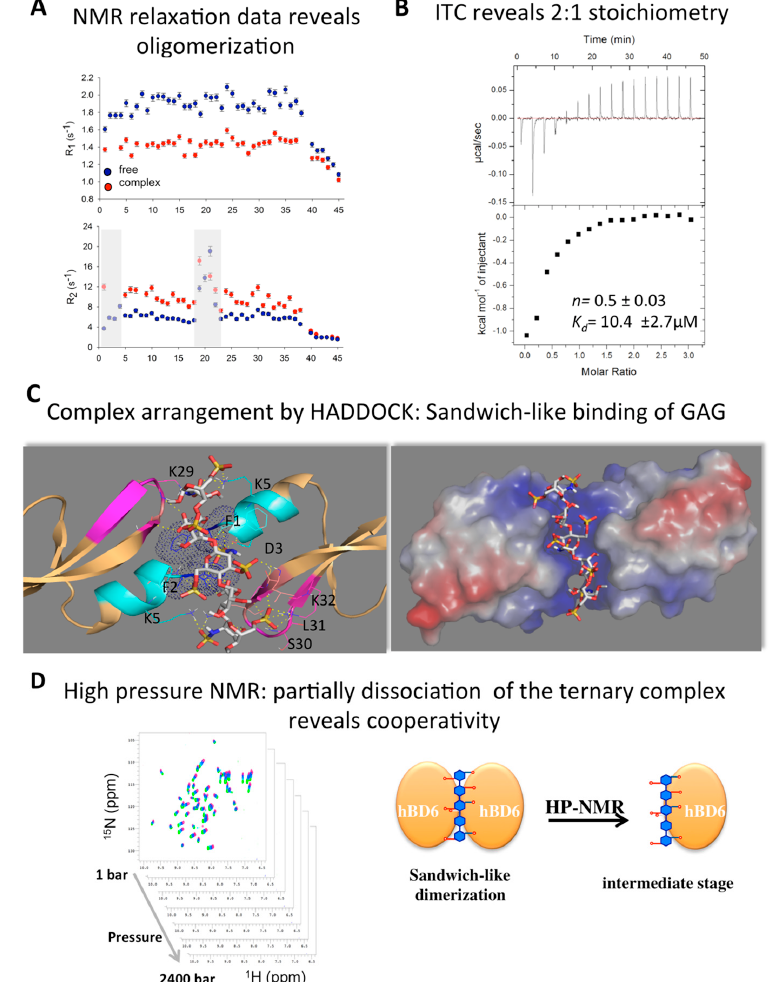
Figure 6. Dimerization and cooperativity during glycosaminoglycan (GAG) recognition by human β‐ defensin (HBD)6. ( A ) NMR relaxation experiments can reveal conformational exchanges and oligomerization (determined using NMR relaxation times) of defensins alone or complexed with GAGs. The R 2 /R 1 ratios are translated during changes in the rotational correlation time, revealing the size of the complex. Note the grey areas for a direct comparison of the R 2 values between the two HBD6 states (free and GAG ‐ bound). ( B ) ITC measurements dissect the binding mechanism of HBD6 and confirm the 2:1 stoichiometry. ( C ) Rendition of the “sandwich ‐ like” dimerization mechanism. The lowest ‐ energy structure of the HBD6 ‐ GAG complex within the highest ‐ scoring NMR ‐ restrained high ambiguity driven docking alternatives is chosen. Residues with substantial chemical shift perturbations upon GAG titration are highlighted in cyan ( α‐ helix) and magenta ( β 2 ‐β 3). Hydrogen bonds and salt bridges formed by the sulfate moieties are represented by yellow dashed lines. Hydrophobic interactions between the aromatic rings of F1 residues from each monomer of HBD6 are represented by dark blue dots (right panel). The electrostatic potential of the ternary complex is indicated. Surface polarity is indicated as positive (blue), negative (red), or nonpolar (white; left panel). ( D ) High ‐ pressure NMR confirms the sandwich ‐ like dimerization mechanism and the induced dissociation of the HBD6 ‐ GAG ternary complex, revealing an intermediate stage. A series of 1 H ‐ 15 N heteronuclear single quantum coherence spectra were recorded, varying the pressure. This data can reveal a snapshot of the first stage of GAG recognition whereby HBD6 exhibits features of a cooperative binding mechanism. This panel is adapted from [41] with permission from the original publisher.